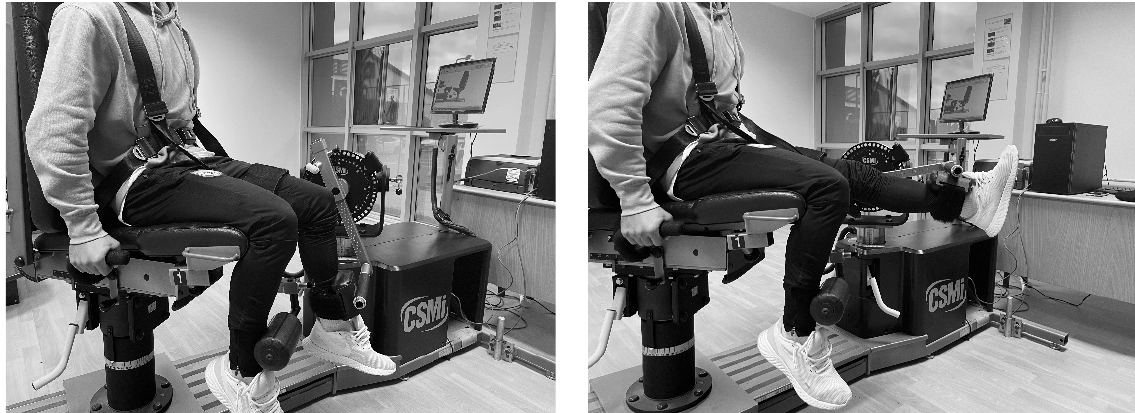
Figure 2. The knee extension and flexion movements by the isokinetic dynamometer.